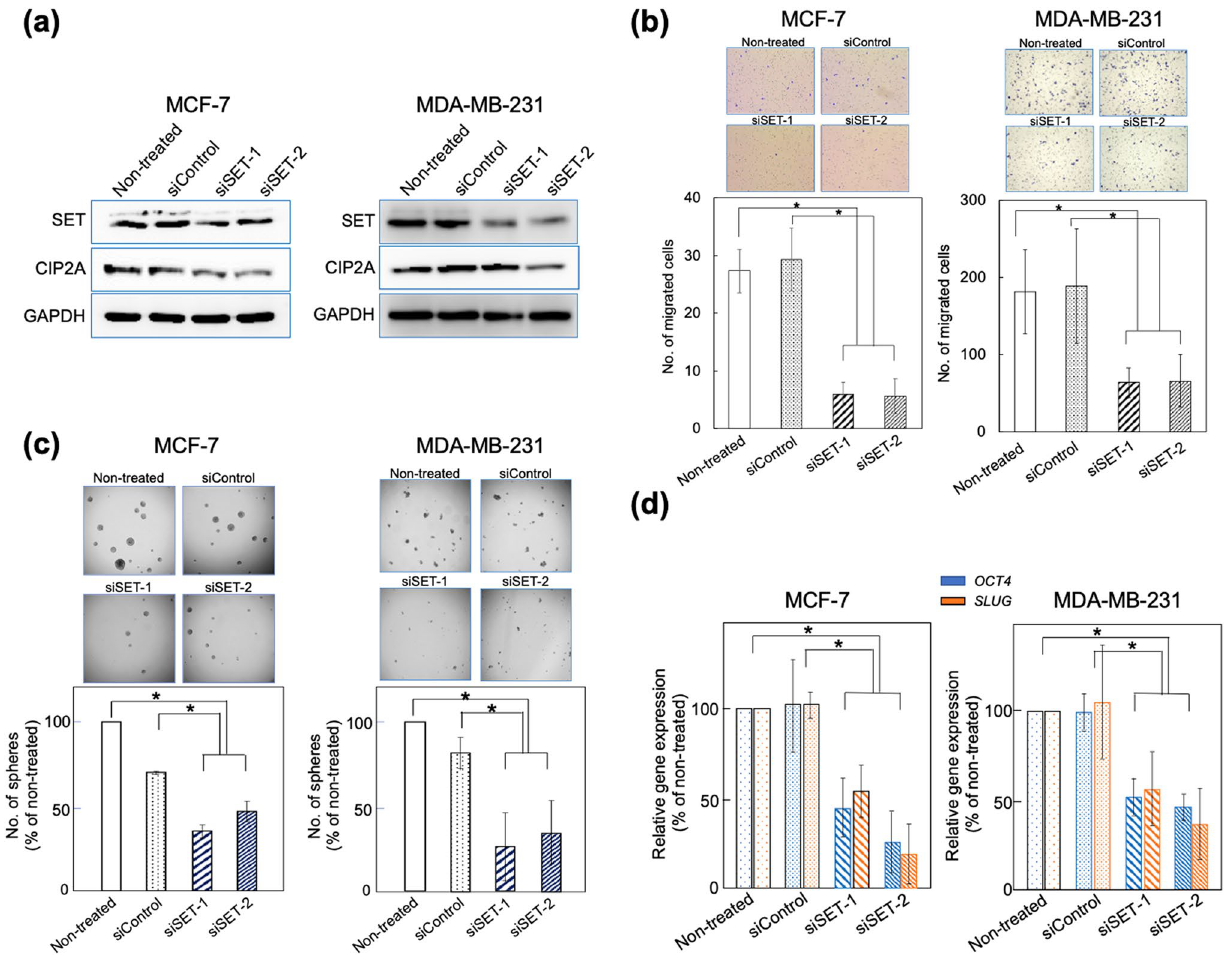
Figure 2. Knocking down of SET with siSETs reduced motility and mammosphere formation in MCF-7 and MDA-MD-231 cells. ( a ) Treatment with siSET-1 and siSET-2 reduced SET protein level, which was associated with reduction of CIP2A. Original full images in the figure were shown in Supplementary information, Figure S1. Due to cut the membrane prior hybridization or due to clear backgrounds, some of blot images have absent membrane edges, but specificities of bands were confirmed by knocking down using siRNAs. ( b ) Motility of MCF-7 and MDA-MD-231 cells was reduced upon SET knockdown. ( c ) SET knockdown inhibited mammosphere formation in MCF-7 and MDA-MB-231 cells. ( d ) OCT4 and SLUG expression in mammospheres was suppressed by SET knockdown in MCF-7 and MDA-MB-231 cells. * P <